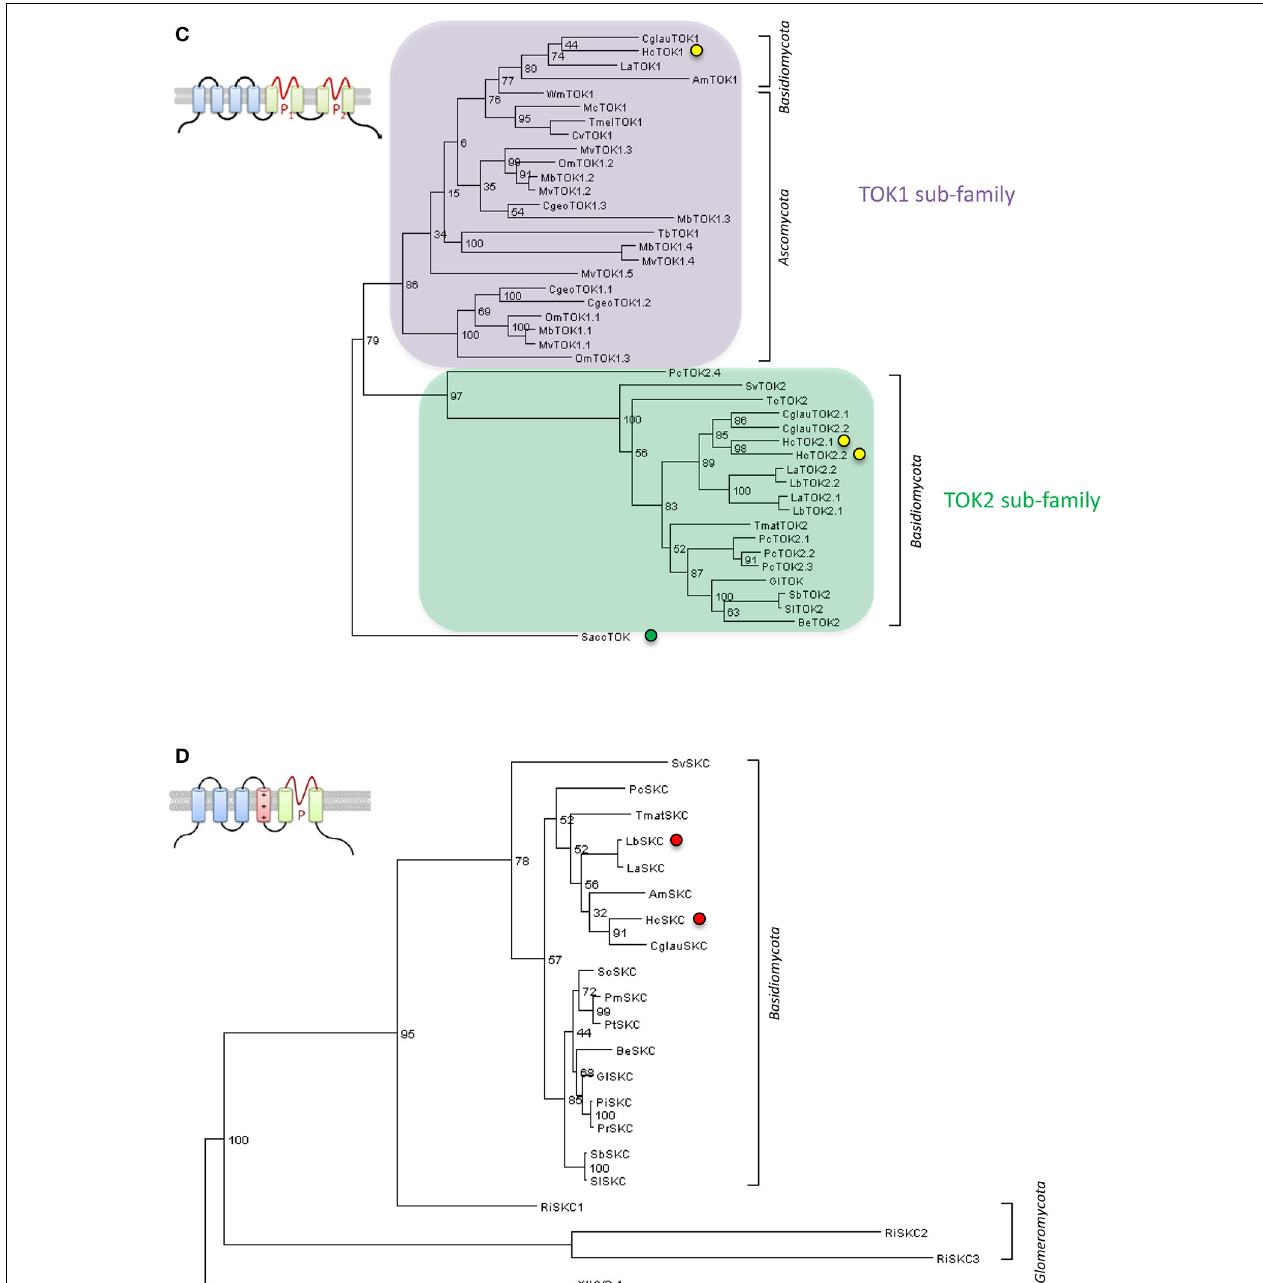
FIGURE 1 | Phylogenetic trees of potassium transport systems from sequenced mycorrhizal fungi. Four families of K + transport systems were identified in sequenced mycorrhizal fungi. Two of them code for putative transporters, for the (A) Trk and (B) HAK families, and the two others for putative ion channels, for the (C) TOK and (D) Shaker-like (SKC) families, respectively. (A) Two sub-families of Trk transporters were identified in Basidiomycota . (C) Two subfamilies of TOK channels were found in Asco- and Basidiomycota . Neither of these two families were identified in the Glomeromycota species Rhizophagus irregularis . (D) No SKC channel was found in Ascomycota fungi (mycorrhizal or not), suggesting the loss of this channel in this clade. Structure models of each family are represented. Transmembrane domains are symbolized by rectangles and pore domains by a P. The voltage-dependent domain of SKC proteins (D) is indicated by a red rectangle ( + + + ). Trees were